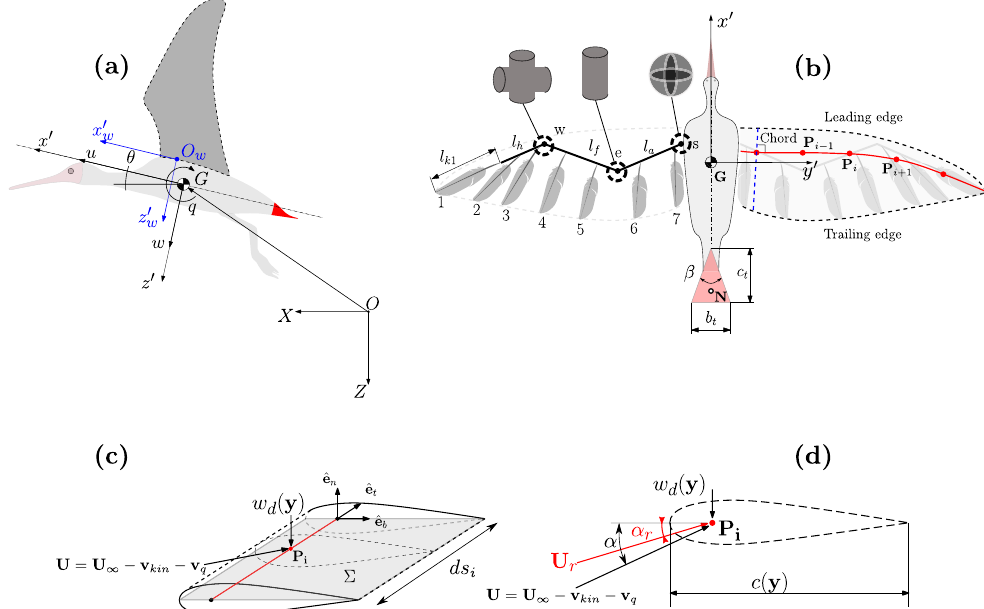
Figure 1. ( a ) Bird model for describing the flight dynamics in the longitudinal plane. The state variables are expressed with respect to the moving body-frame located at the flier’s center of mass G ( x ′ , z ′ ) . These state variables are the component of forward flight velocity, u , the velocity component of local vertical velocity, w , the orientation of this body-centered moving frame with respect to the fixed frame, θ and its angular velocity, q . A second frame O ( x ′ w , z ′ w ) is used to compute the position of the wing, relative to the body. The wings (dark gray) and the tail (red) are the surfaces of application of aerodynamic forces. ( b ) Top view of the bird model. The left wing emphasizes a cartoon model of the skeleton. The shoulder joint s connects the wing to the body via three rotational degrees of freedom (RDoF), the elbow joint e connects the arm with the forearm via one RDoF and the wrist joint w connects the forearm to the hand via two RDoF. Each feather is attached to a bone via two additional RDoF, except the most distal one ”1” which is rigidly aligned with the hand. The right wing further emphasizes the lifting line (red) which is computed as a function of the wing morphing. The aerodynamic forces generated on the wing are computed on the discretized elements P i . The tail is modelled as a triangular shape with fixed chord c t and maximum width b t that can be morphed as a function of its opening angle β . ( c ) Wing element i between two wing profiles, identifying a plane (cid:31) containing the lifting line (red). ( d ) Cross section of the wing element, containing the chord point P i where the velocities are computed (Color figure